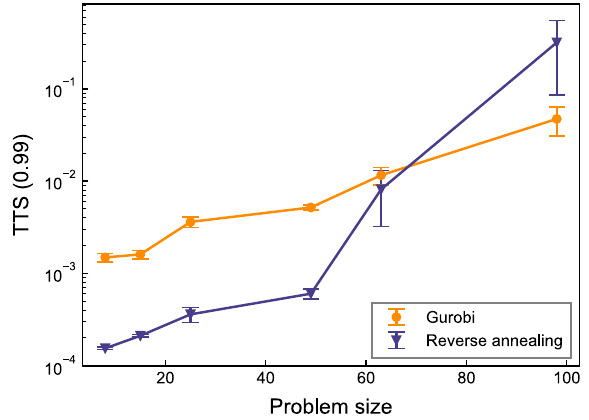
Figure 4. Comparison of TTS performance. The orange circle and purple triangle show mean value of TTS(0.99) of Gurobi and reverse annealing, respectively. The error bars indicate the standard error.